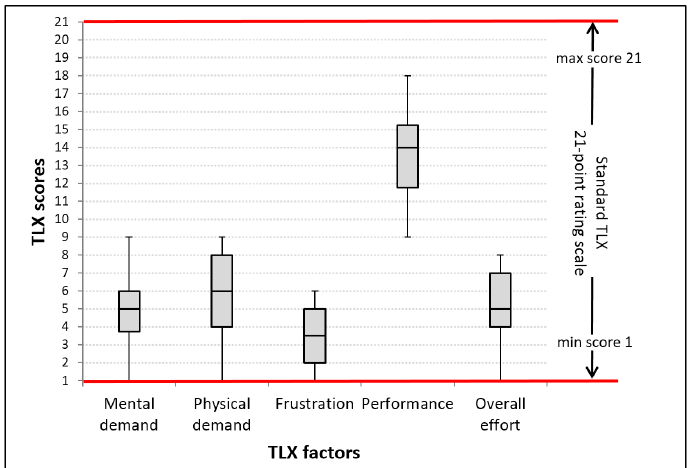
Figure 13. Users’ opinions on perceived workload of magnet-based text entry, obtained via paper- and-pencil version of the NASA-TLX rating